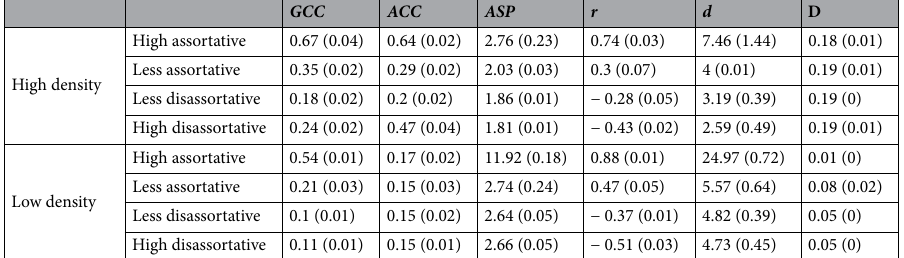
Table 2. Topological properties of a sample of the generated synthetic networks (of size 250) used in the analysis; Mean (and standard deviation of) GCC & ACC: Global and Average Clustering Coefficients, ASP : Average Shortest Path, r : Assortativity Coefficient value, d : diameter, and D : graph